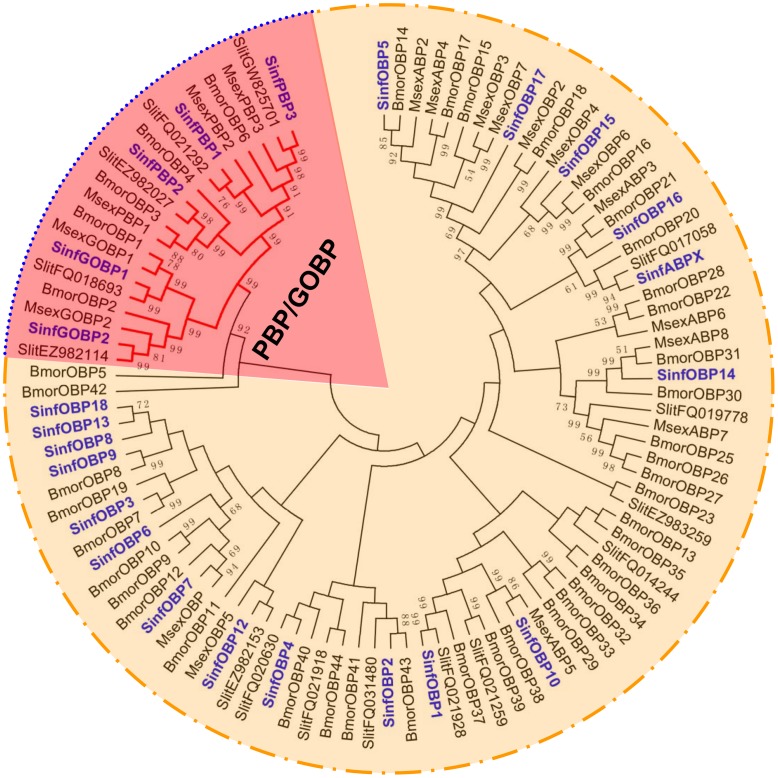
Phylogenetic tree of putative OBPs from S. inferens, M. sexta, S. littoralis and B. mori.PBP/GOBP clade is marked in red. The S. inferens translated unigenes are shown in blue. Accession numbers are given in Table S3. The tree was constructed with MEGA5.0, using the neighbour-joining method. Values indicated at the nodes are bootstrap values based on 1000 replicates, and the bootstrap values <50% are not shown. Sinf, Sesamia inferens; Msex, Manduca sexta; Slit, Spodoptera littoralis; Bmor, Bombyx mori.